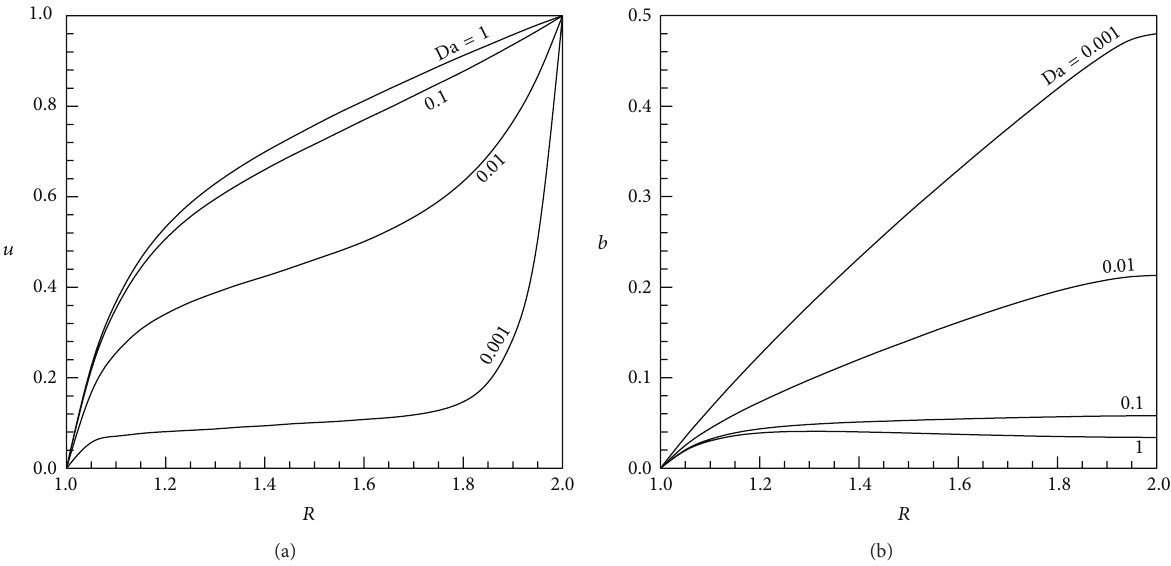
Figure 6: Various profiles for Ha = 10 and different values of Da when the inner cylinder is perfectly insulated while the outer one is perfectly conducting: (a) velocity and (b) induced magnetic field.